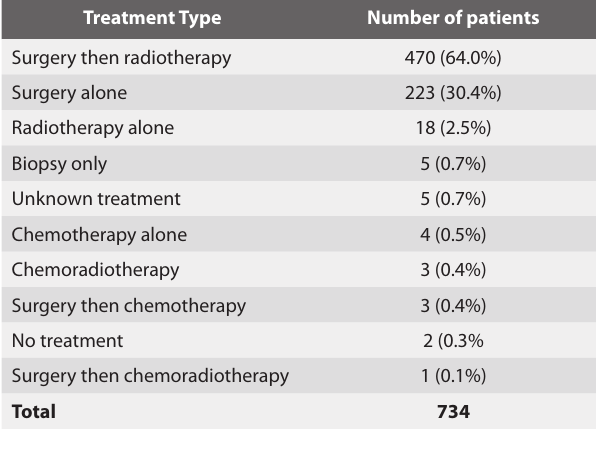
Table 3. Treatment of